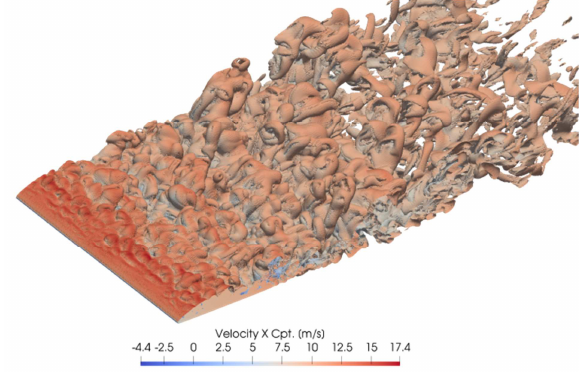
Fig. 15 . Iso-surface of instantaneous vorticity 500 1/s . Coloured by streamwise velocity.